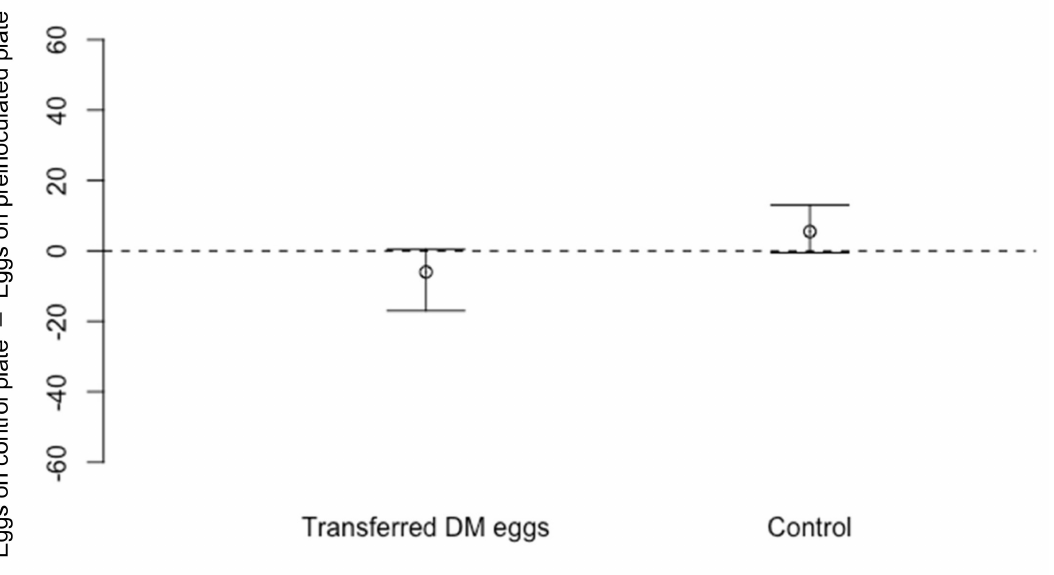
Figure 5. Differences in numbers of eggs laid by Drosophila suzukii (Median ± 95% confidence intervals) laid on cornmeal media dishes which contained transferred D. melanogaster (DM) eggs compared to eggs laid on a blank dish ( n = 20, p = 0.07). In the control experiment, D. suzukii laid fewer eggs on dishes pre-exposed to D. melanogaster compared to unexposed dish, but this difference was not statistically significant ( n = 20, p =